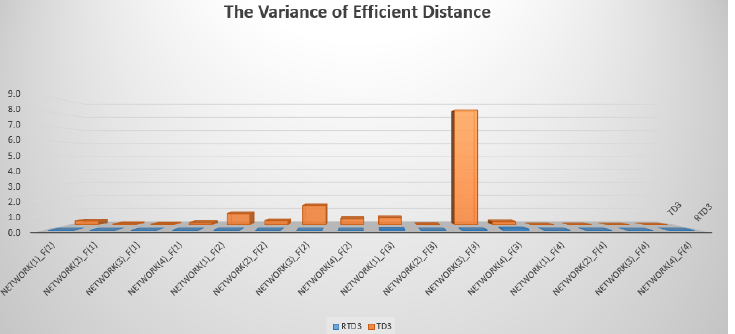
Figure 12. The variances of efficient distance of RTD3 (blue) and TD3 (orange) under four reward function settings when episode ranges from 30,000 to